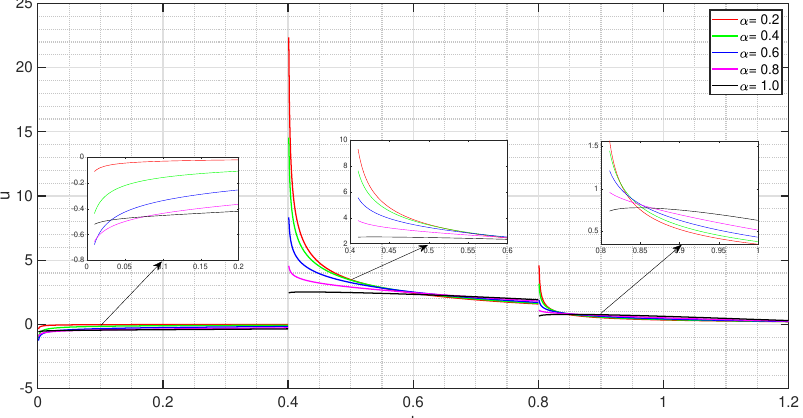
Figure 2. The implicit solutions of Example (49) via α k ∈ { 0.2,0.4,0.6,0.8,1.0 } when φ k ( t ) =